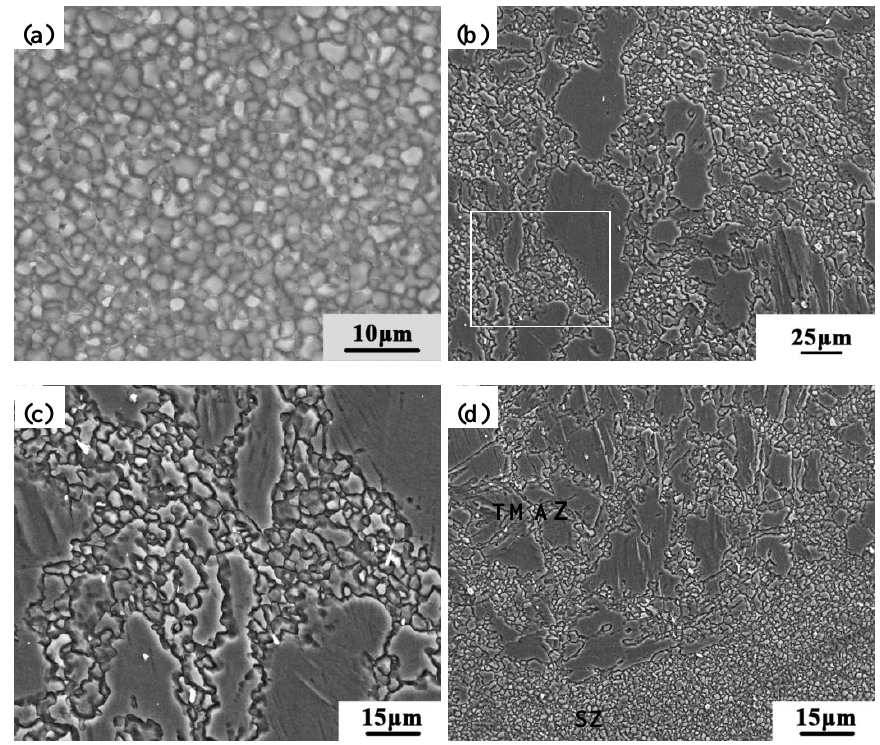
Figure 5. Representative SEM images of the SFSP AZ31 magnesium alloy: ( a ) SZ; ( b ) TMAZ; ( c ) High magnified image of the marked position in Figure 5b; ( d ) TMAZ/SZ.